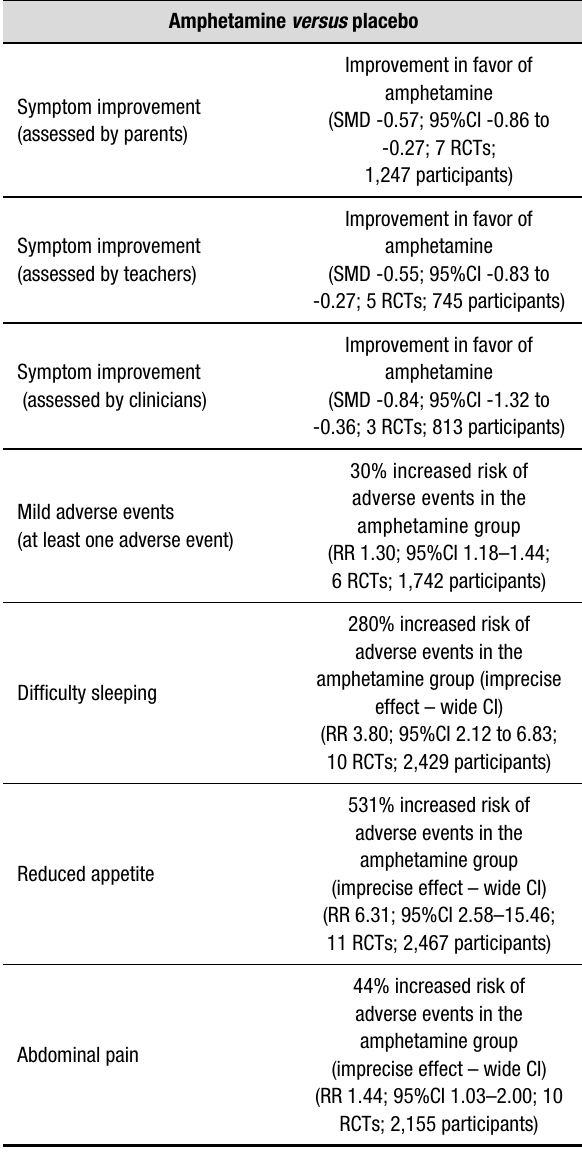
Table 2. Summary of the main outcomes: amphetamine for attention deficit hyperactivity